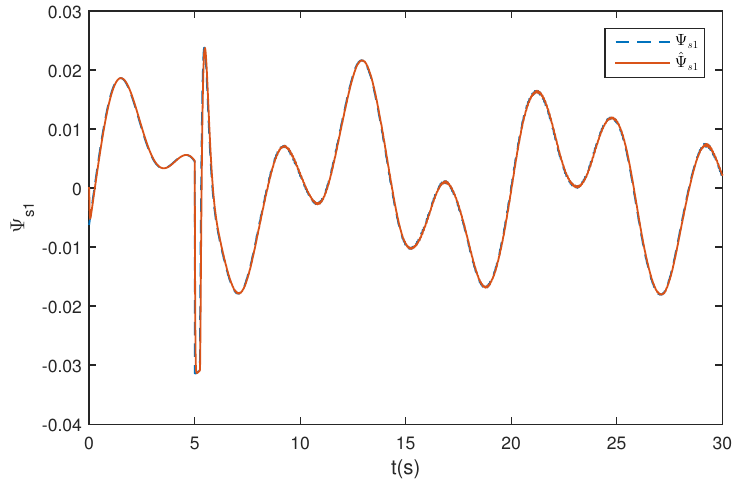
Figure 23. Estimation of Ψ s 1 under NBD.